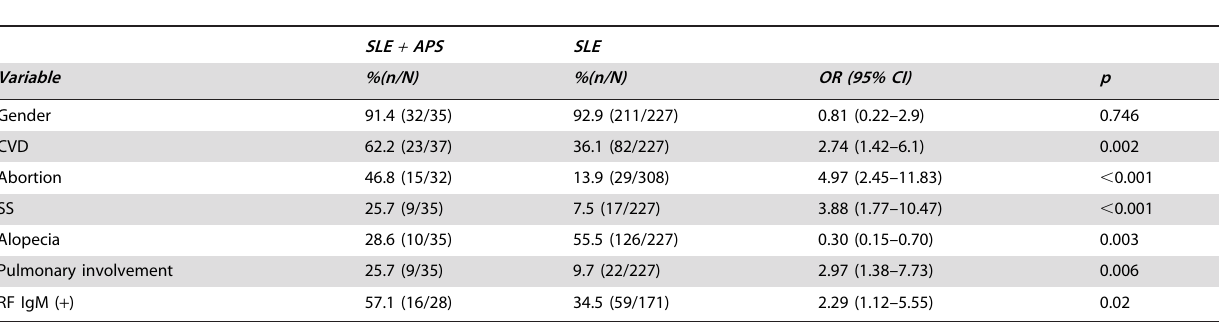
Table 2. Factors associated with APS in SLE (bivariate